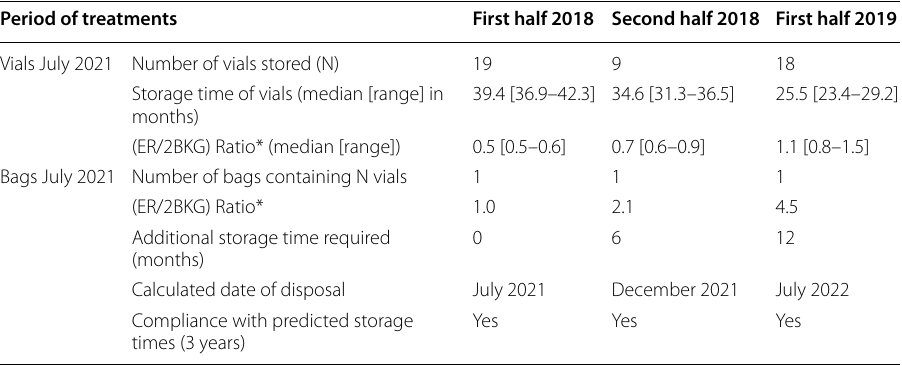
* ER Exposure rate measured in contact with the container; 2BKG background